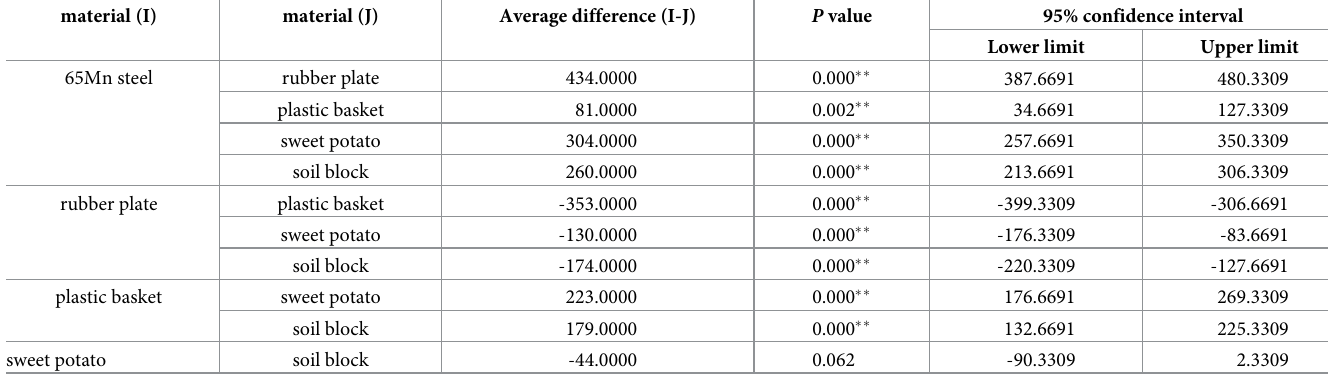
Table 6. Multiple comparisons of the influence of sweet potato collision materials on the area of epidermal destruction.